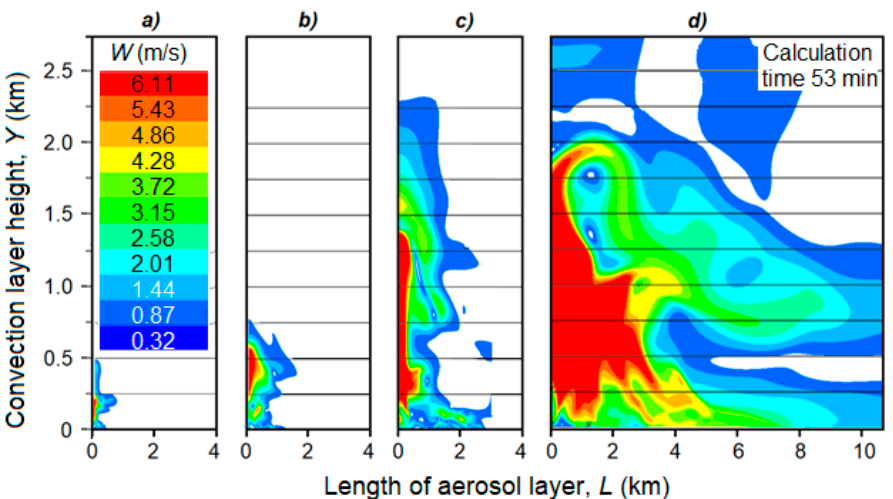
Figure 9. Thermal convection triggered in a windless atmosphere at TLR = 8.5 °C/km by artificial aerosol layer having an area of: ( a ) S 1 = 0.01 km 2 ; ( b ) S 2 = 0.1 km 2 ; ( c ) S 3 = 1 km 2 and ( d ) S 4 = 10 km 2 .